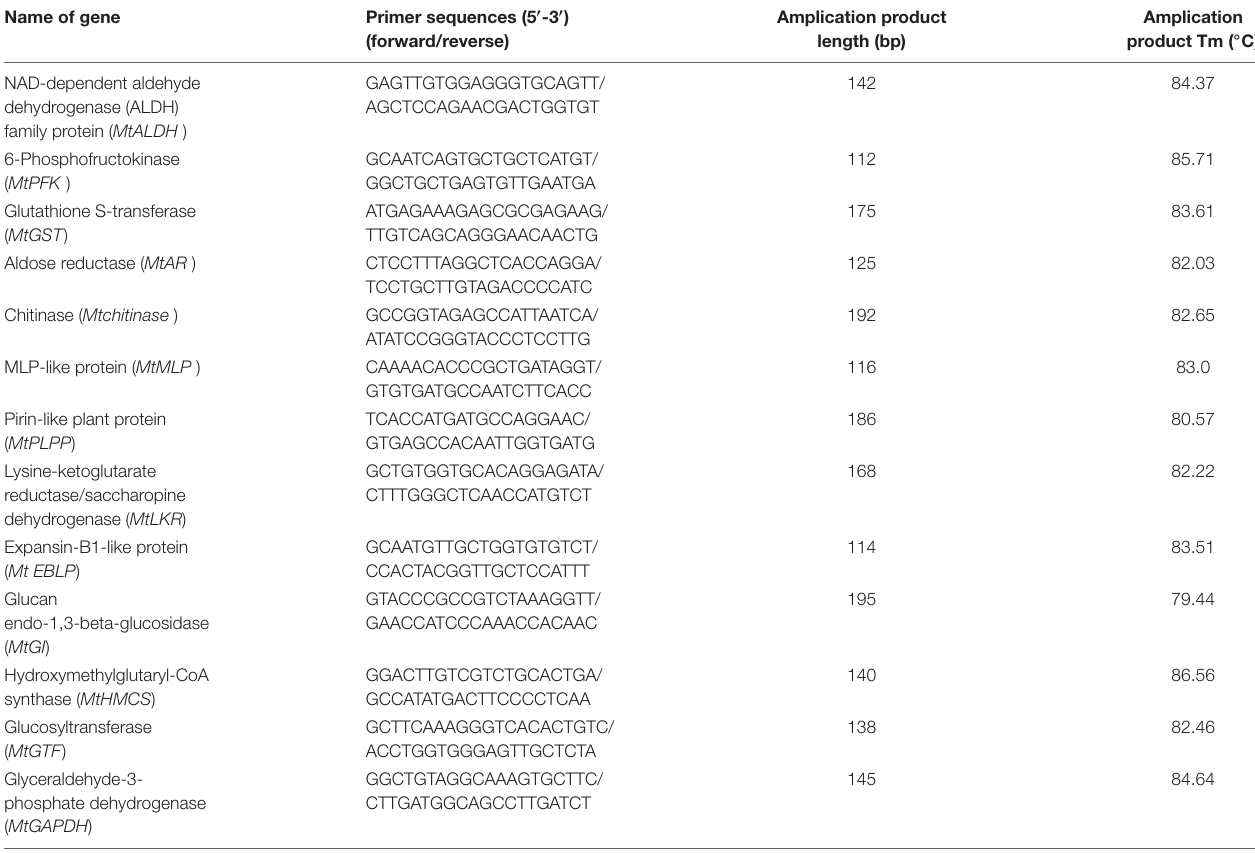
TABLE 1 | Sequence of primers used in